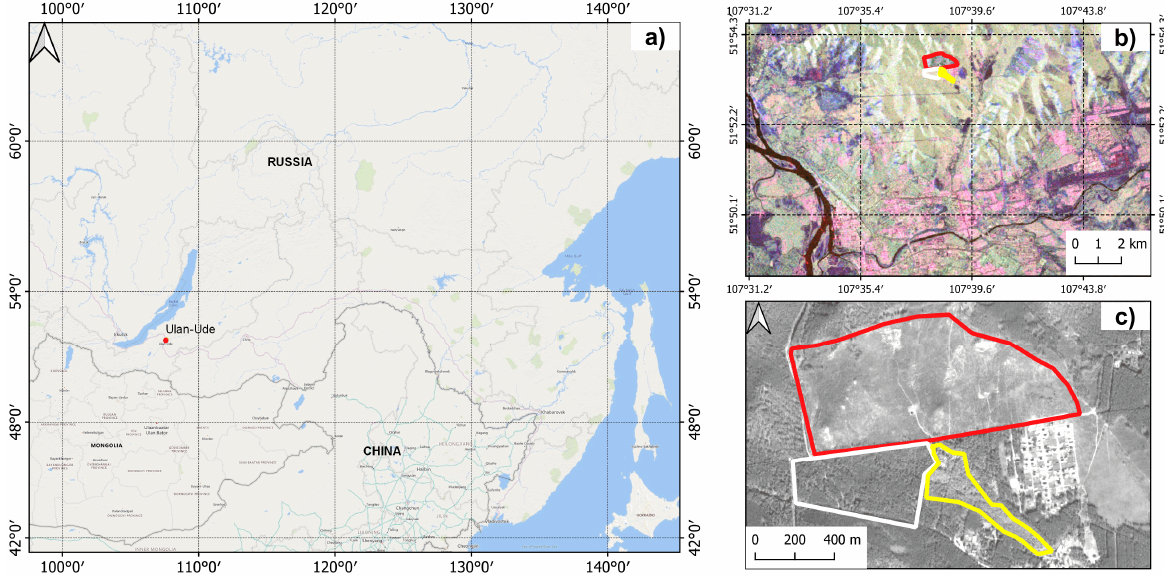
Figure 1. ( a ) Test site location on the map; ( b ) Pauli RGB color composite image for the ALOS-2 PALSAR-2 quad-polarimetric data, 30 August 2019; ( c ) Resurs-P satellite image with test site outlined by red line and two control sections (white and yellow polygons) of mature unburned forest.